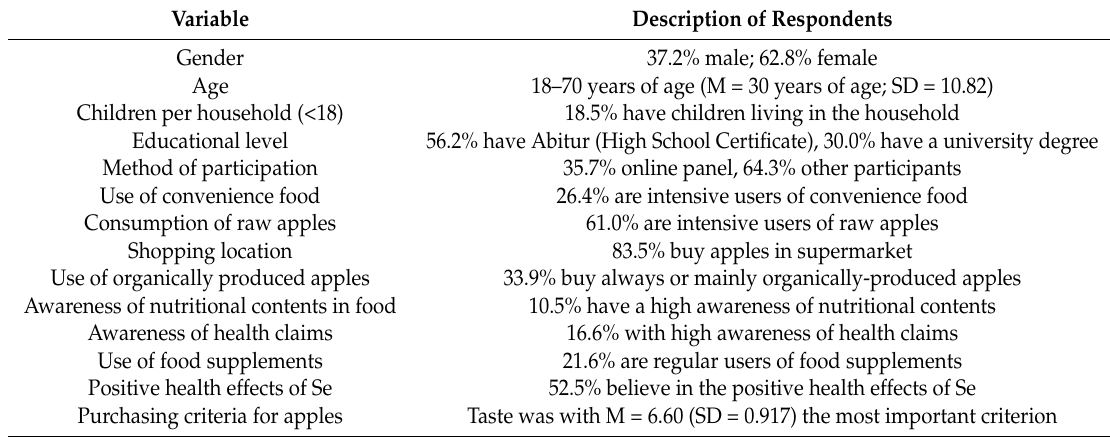
Table 2. Characteristics of the consumer sample (for additional information concerning important purchasing criteria for apples, refer Table